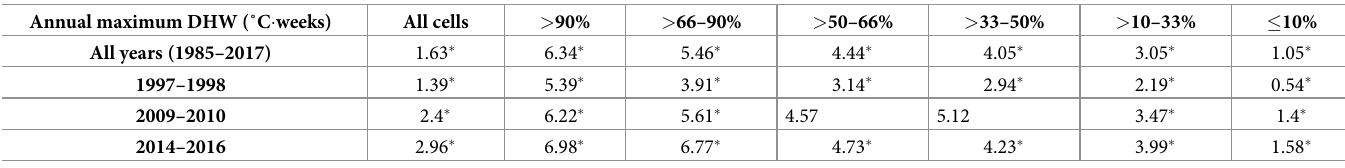
Table 2. Thermal stress for reef cells with different bleaching